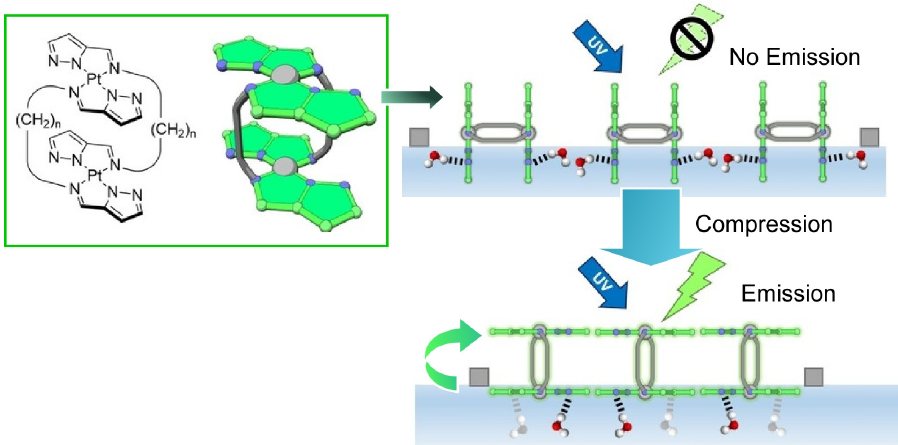
Figure 24. Submarine emission in which a double-paddle platinum complex is used to control the luminescence of cyclic amphiphilic molecules at the air-water interface by means of mechanical manipulation. Reprinted with permission from Reference [199]. Copyright 2019 Wiley-VCH.